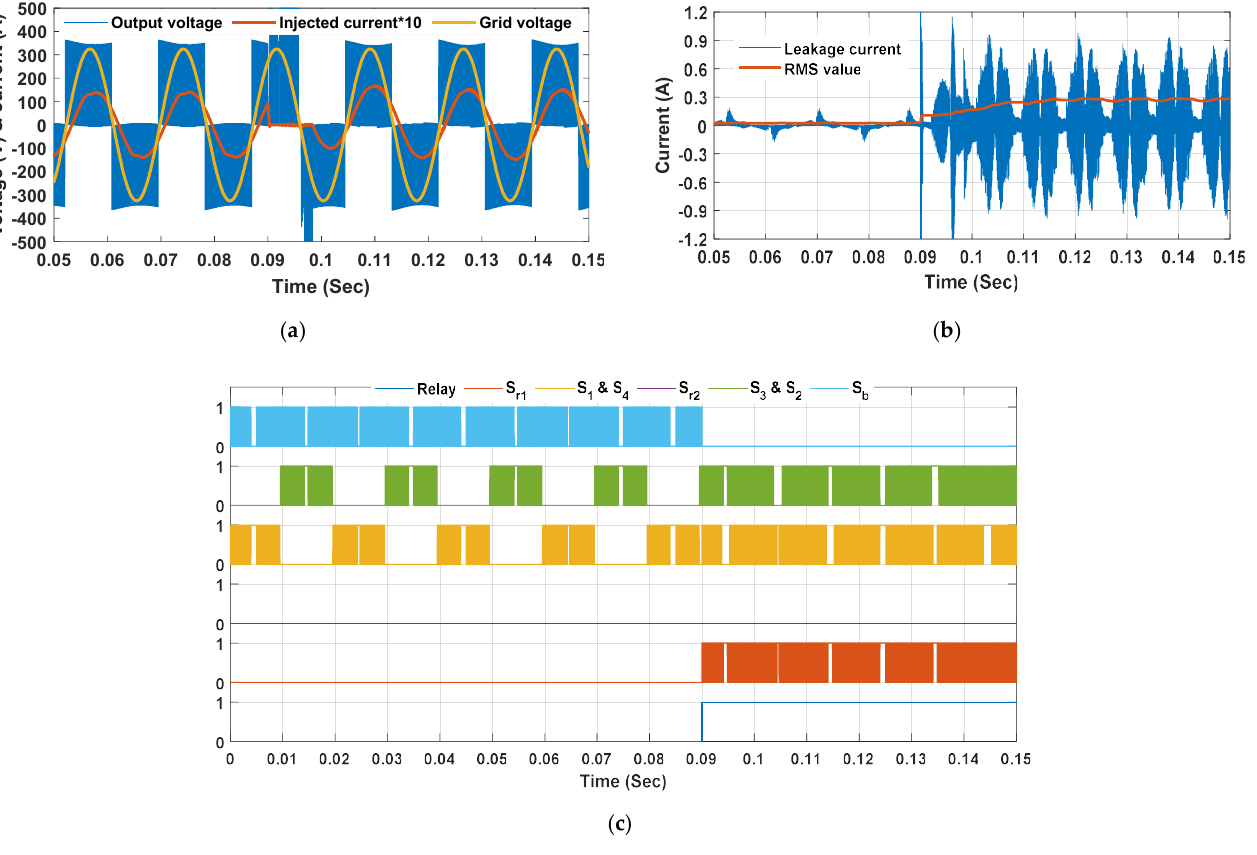
Figure 15. Performance when the bidirectional switch fails, ( a ) output voltage, injected current and grid voltage, ( b ) leakage current, ( c ) switching and relay signals.